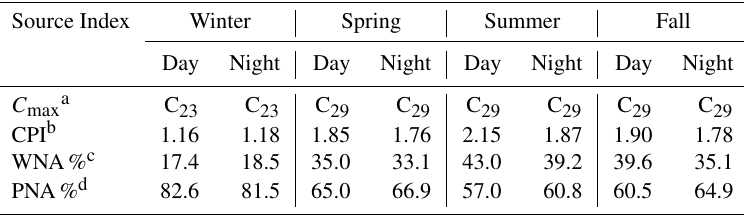
Table 2. Source indices for particulate-bound n -alkane in Beijing. Source Index Winter Spring